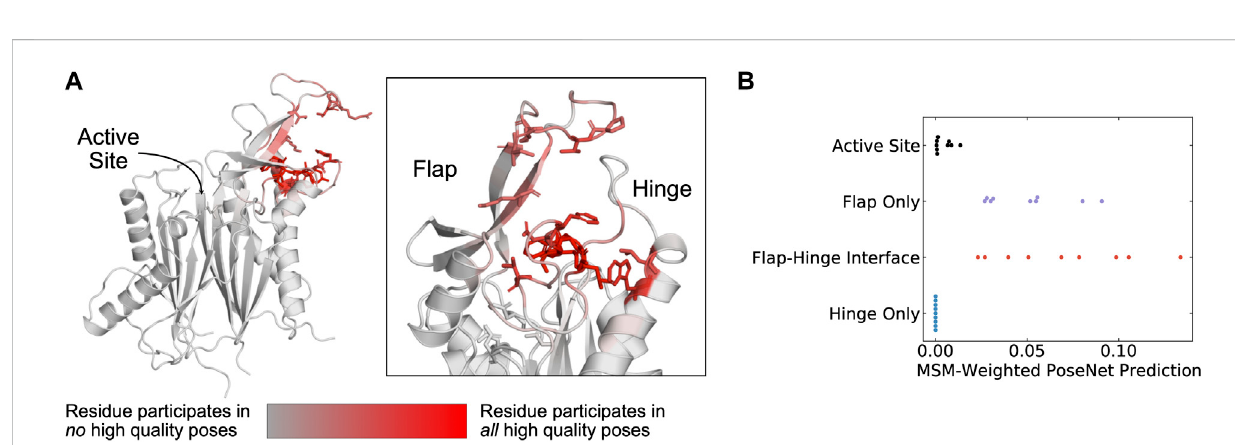
FIGURE 4 The AtomNet PoseRanker neural network predicts that poses found at the fl ap-hinge interface are more crystal-like. (A) A PPM1D AlphaFold structure colored by the frequency with which residues participate in high-quality poses indicates that residues needed for high-quality poses are found at the fl ap-hinge interface. Residues in dark red most frequently contact the GSK2830371 compound in its high-quality poses. High-quality poses were those poses that received a PoseRanker score of 0.5 or higher. A contact was de fi ned when a ligand heavy atom was within 4 Å of a protein heavy atom. (B) The MSM-weighted AtomNet PoseRanker (ANPR) predictions across different binding sites show that the fl ap-hinge interface receives higher ANPR scores. Each point represents a different CAA compound. When there were multiple poses in one of the binding site categories, we selected the pose with the highest ANPR score. We de fi ned the hinge as residues 150 – 166 and the fl ap as residues 219 –